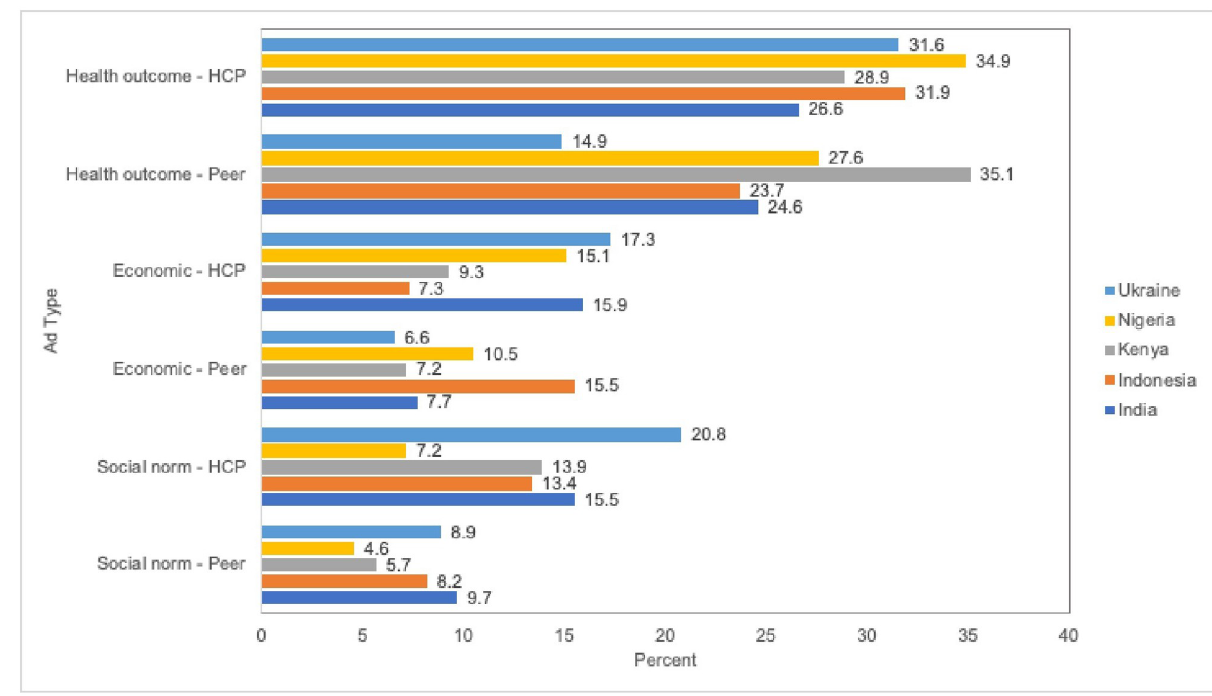
Fig 2. Participants’ preferred vaccine message among the six ads � . � Pearson chi2(20) = 56.8347 Pr = 0.000.